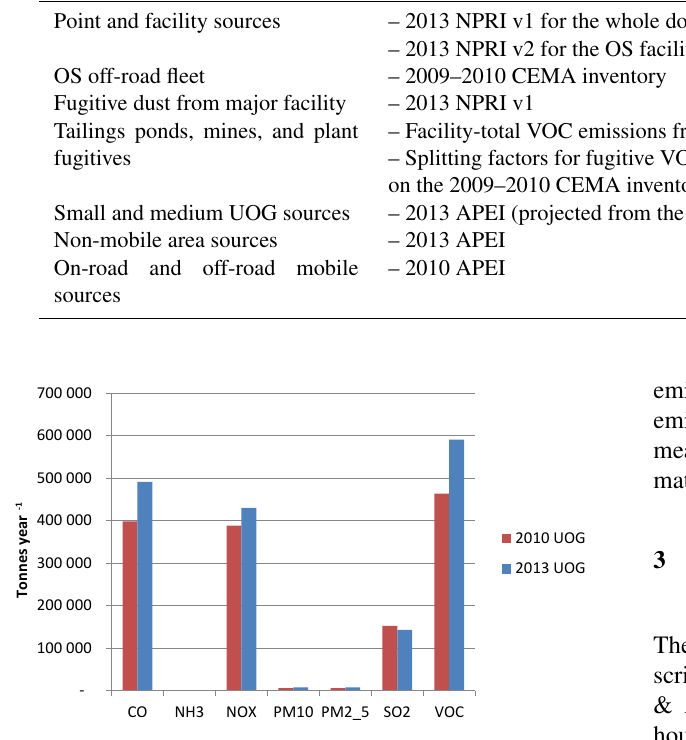
Figure 3. Comparison of national CAC emissions between the year-2000-based projected 2010 UOG inventory and the year-2011- based projected 2013 UOG